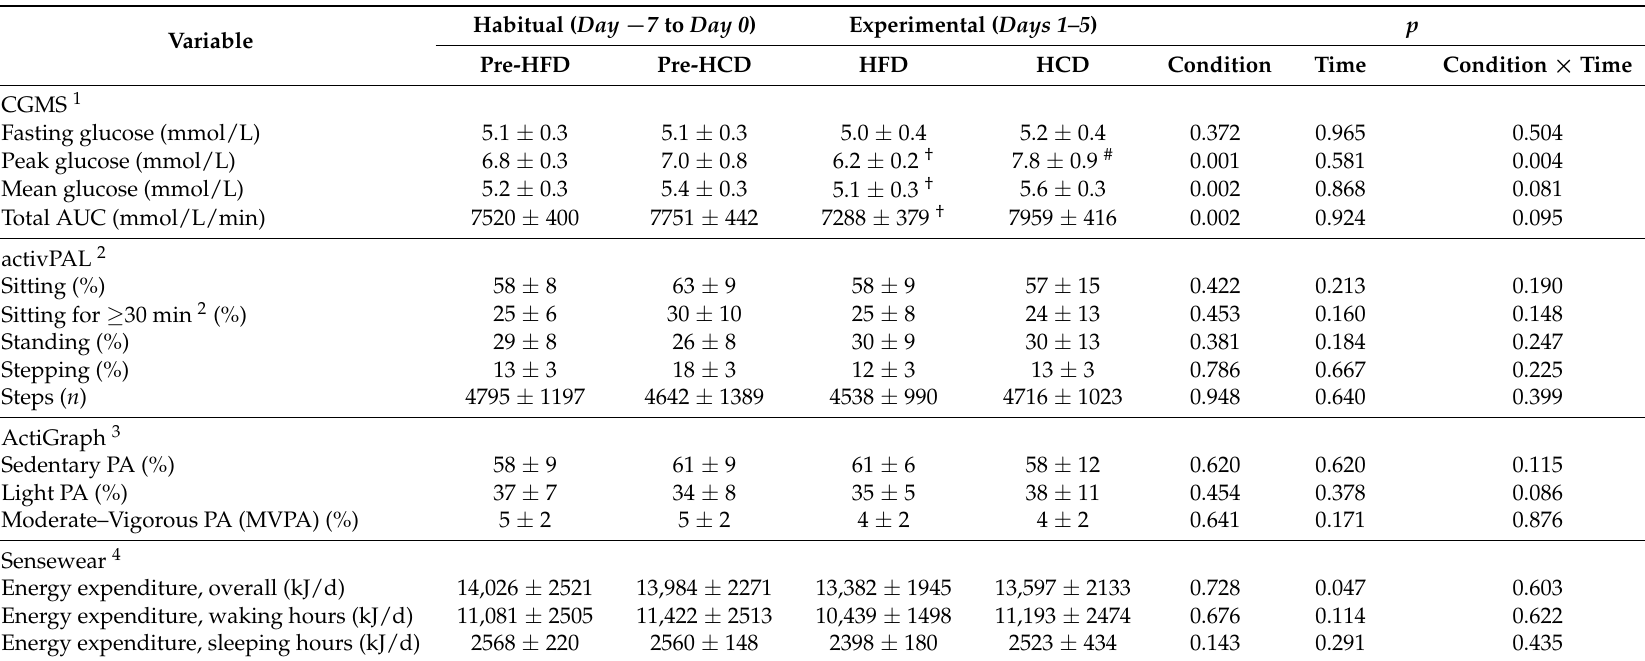
Table 2. Activity and glucose monitor analysis across the habitual ( Day − 7 to Day 0 ) and experimental ( Days 1–5 ) periods for overweight, sedentary males ( n = 8).